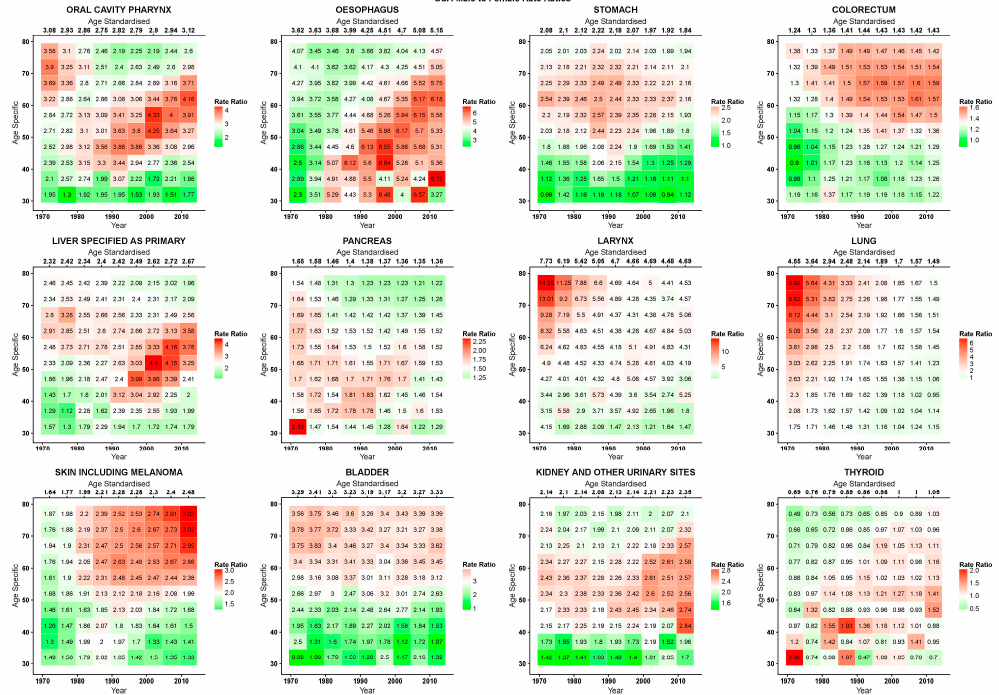
Figure 3. Heatmap tables of age-specific and age-standardised quinquennial male-to-female mortality rate ratios in epithelial cancers in the rate ratios in epithelial cancers in the USA.